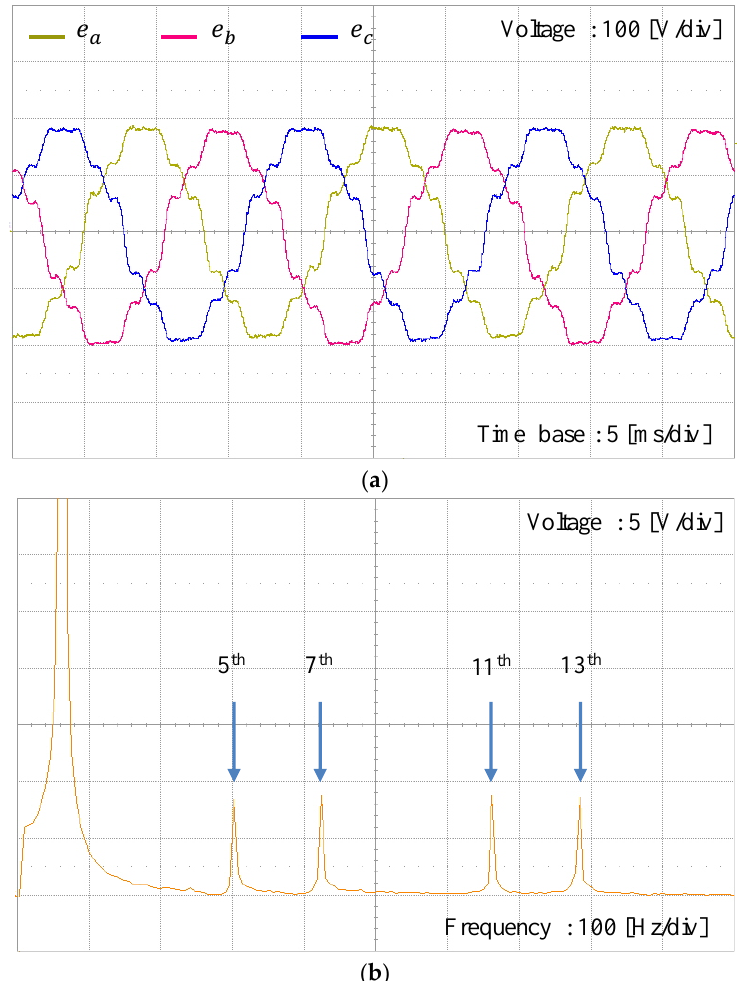
Figure 14. Distorted three-phase grid voltages used in the experiments. ( a ) Three-phase distorted grid voltages; ( b ) FFT result of a -phase grid voltage.